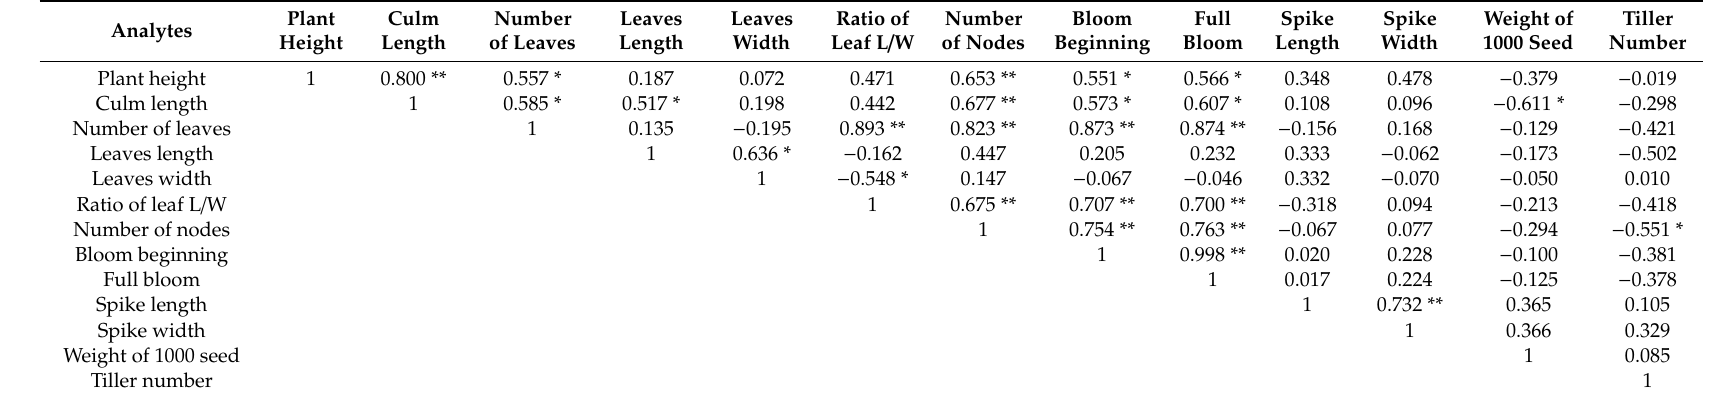
Table 4. Pearson’s correlation coe ffi cients between the main morphological characteristics in S. italica